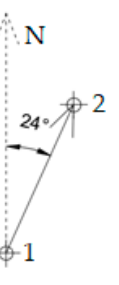
Figure 5. Graph of the HWY 4 from A to B.